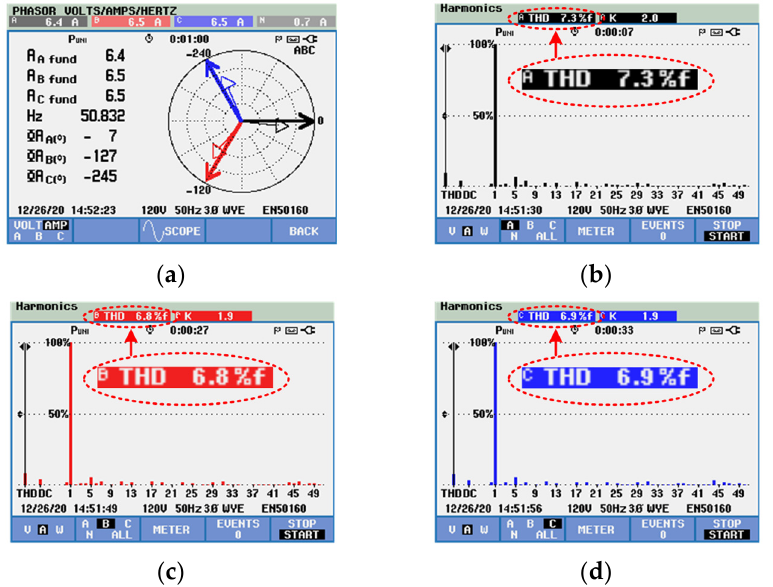
Figure 15. Power quality analysis results of conventional methods. ( a ) The measurement results; ( b ) THD of phase A grid-connected current; ( c ) THD of phase B grid-connected current; ( d ) THD of phase C grid-connected current.